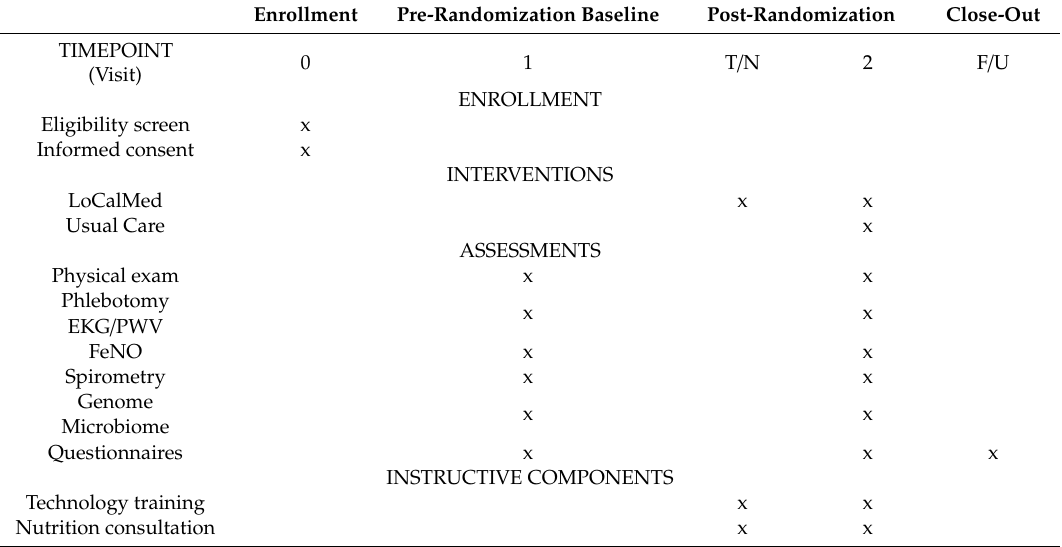
Figure 2. Study design of FIREHOUSE Trial. All participants will be enrolled during the enrollment period at Visit 0. At Visit 1, cohort will complete the dietary assessment/food frequency questionnaire, receive routine medical care, and obtain baseline measurements. Randomization will then occur and groups will be assigned to either LoCalMed or Usual Care groups. LoCalMed Dietary and Intervention group will receive weekly or biweekly technology-driven nutrition visits as scheduled, whereas Usual Care group will receive quarterly flyers to perform routine medical care. Follow-up measurements at Visit 2 will be collected at the end of the 6-month intervention for both groups. The World Trade Center-Health Program (WTC-HP) will be available throughout the time period to all participants to provide other medical care. Table 2. Schedule of enrollment, intervention, and assessment.